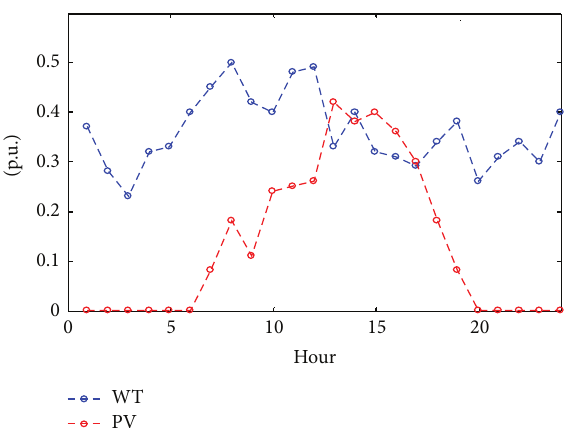
Figure 4: Power forecast of load demand. between 7 p.m. to 9 p.m., implying that these units are put into operation due to the high spot prices in these